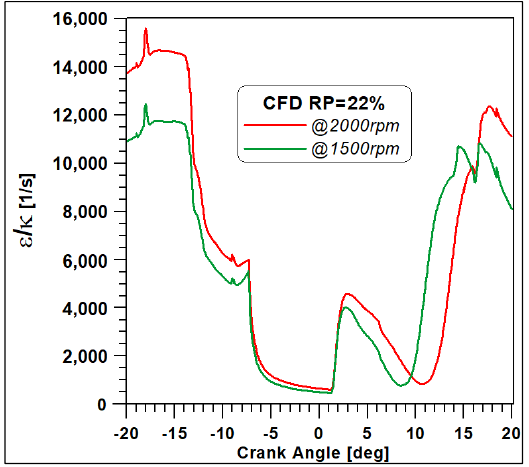
Figure 3. Comparison of specific turbulent dissipation rate for two different engine speeds.